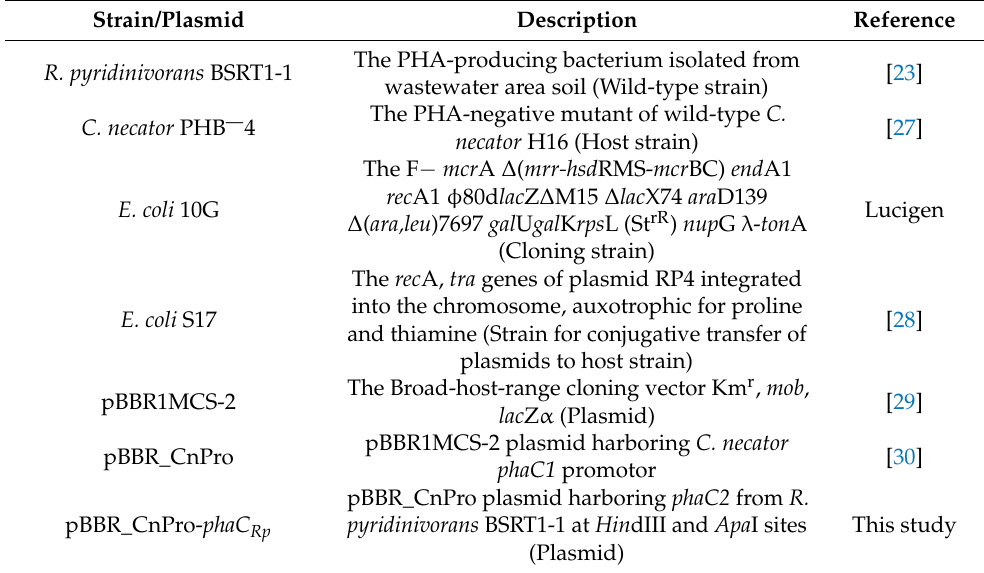
Table 1. Bacterial strain and plasmids used in this study.